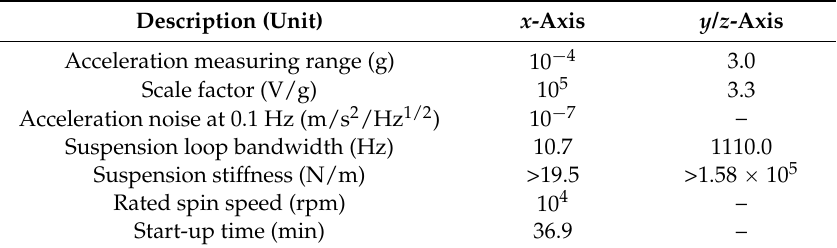
Table 5. Summary of main design specifications of the NEP instrument prototype.